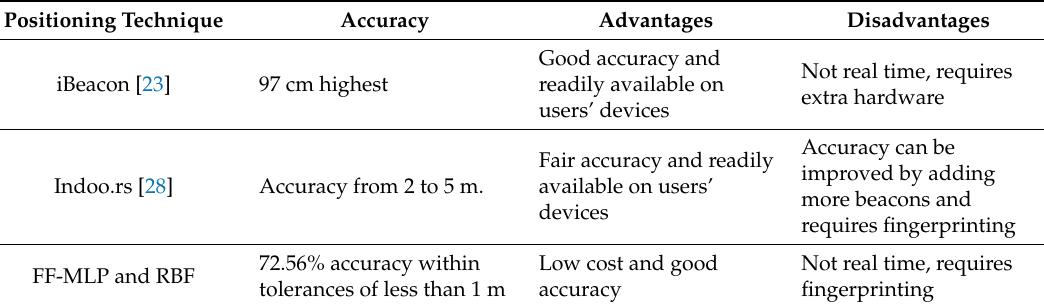
Table 4. Review of Bluetooth positioning